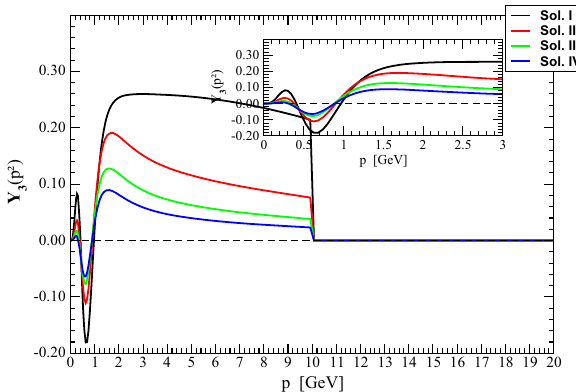
Fig. 22 X ( 3 ) ( p 2 ) from inverting the Dyson–Schwinger equations